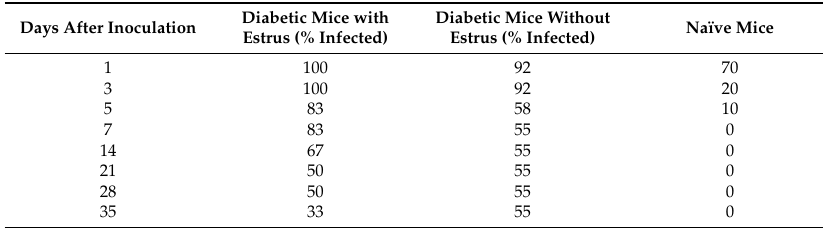
Table 1. Vaginal infection induced in diabetic and naïve